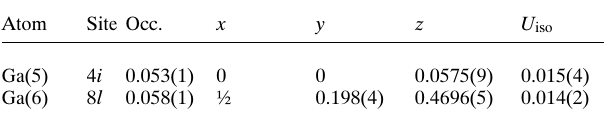
Table 2. Atomic coordinates and displacement parameters (in Å 2 )